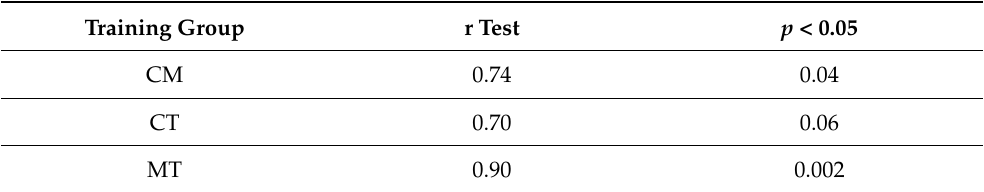
Table 5. Rho-Spearman 1 correlation between the orientation and planning time and the number of errors during the whole